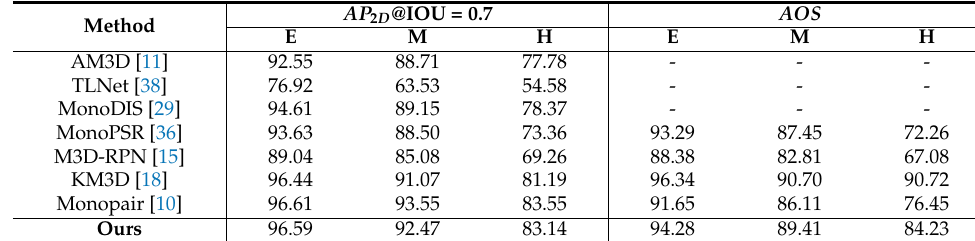
Table 3. Evaluation for 2D detection of cars on test by AP 2 D and AOS metrics: E, M, and H indicate the levels from Easy, Moderate, to Hard.